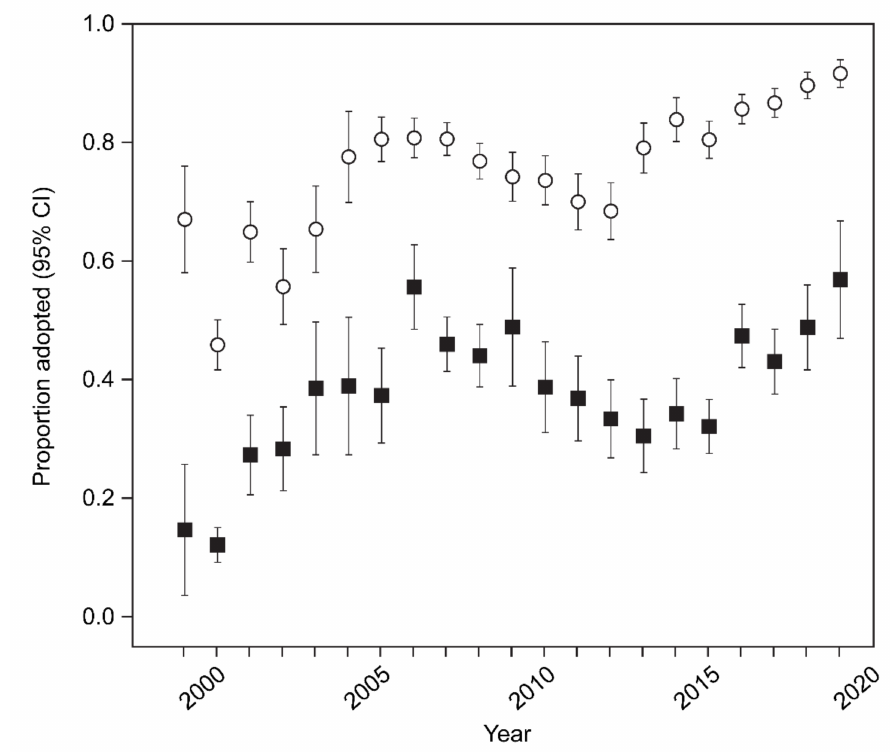
Figure 4. The proportion of kittens and adult cats adopted between 1999 and 2019 through the trap–assess–resolve (TAR) program run by Lonely Miaow, Auckland, New Zealand. Open symbols represent kittens and filled symbols represent adults. Error bars represent 95% confidence